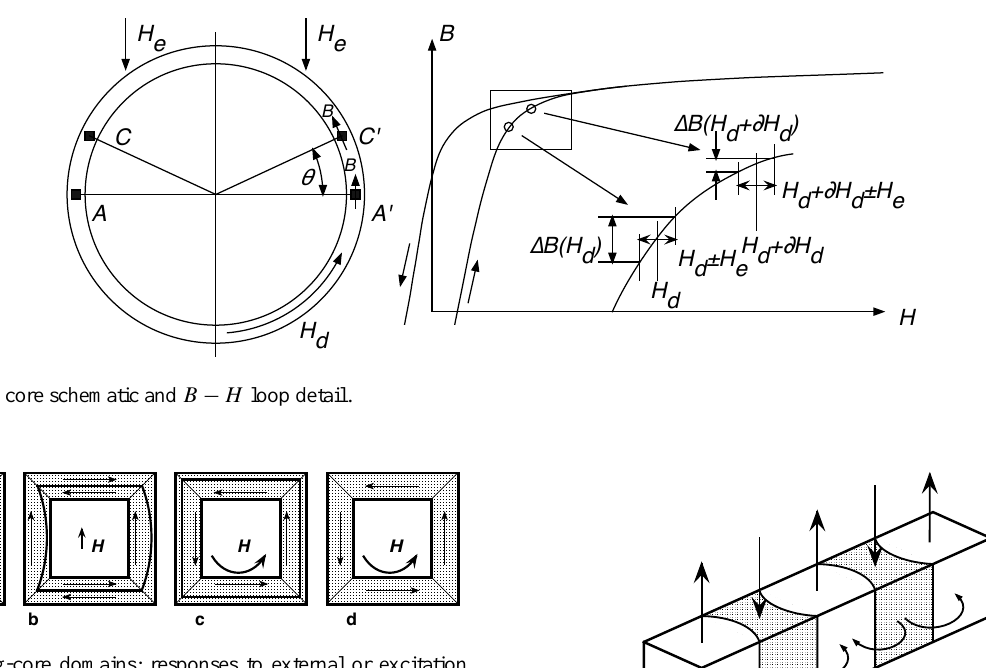
Figure 5. Ring-core domains: responses to external or excitation fields: (a) a demagnetized ring core; (b) a ring core exposed to external field H , depicting enhanced domains with magnetization parallel to H ; (c) a ring core exposed to a drive field H , depicting enhanced domains with magnetization parallel to H ; (d) a ring core exposed to a saturating drive field H , depicting single domains with magnetization parallel to H .